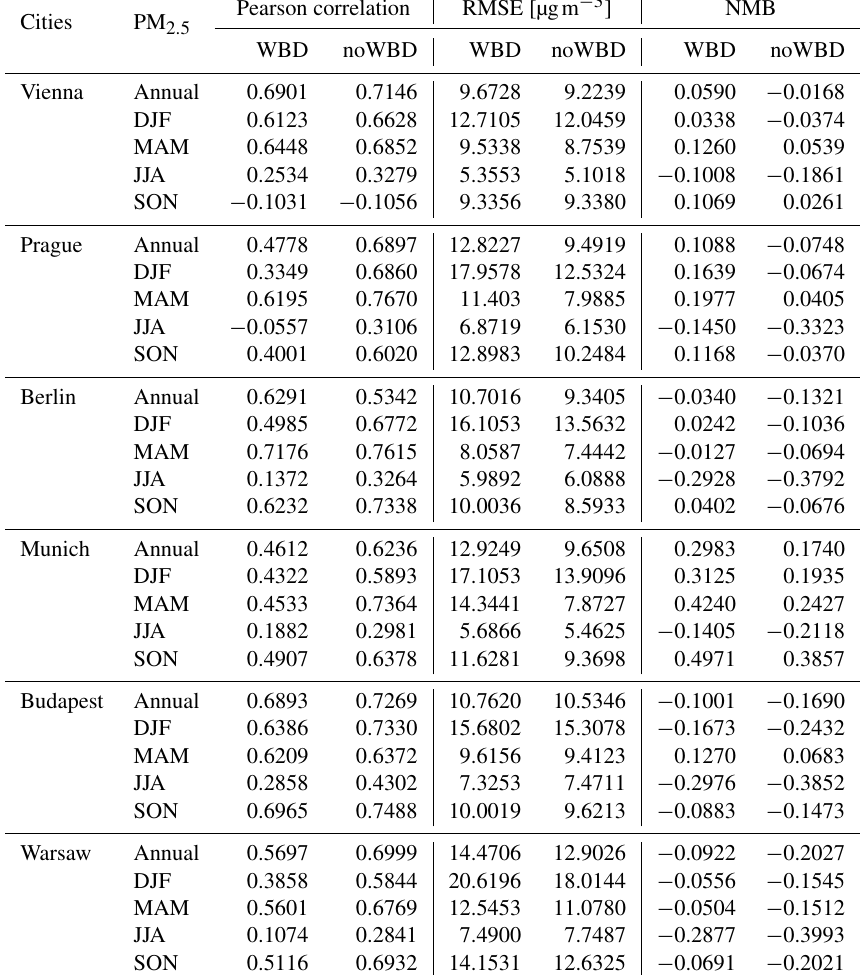
Table 1. Annual and seasonal statistical measures (Pearson correlation, RMSE, NMB) for PM 2 . 5 for both WBD and noWBD ISORROPIA simulations calculated from the daily averages. Cities PM 2 .